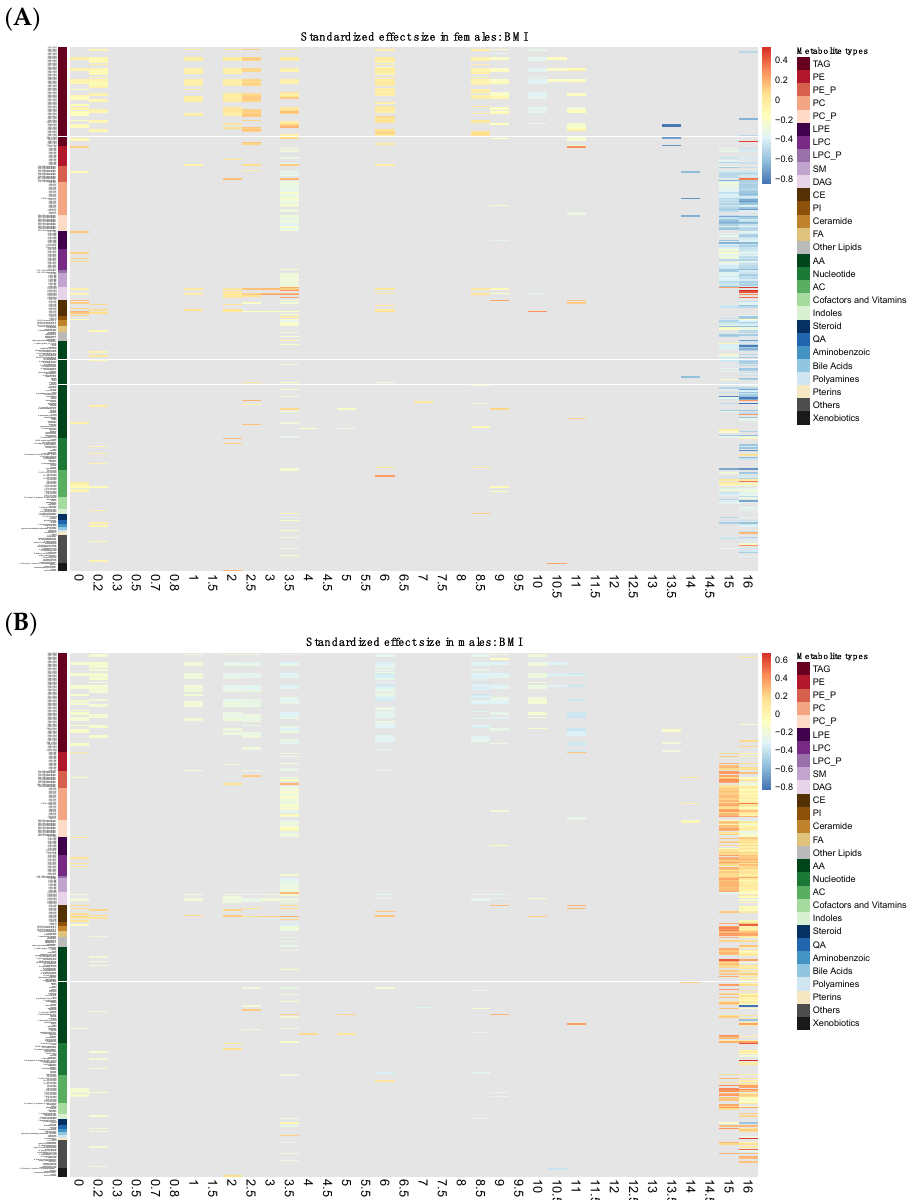
Figure 5. Time-window specific analysis: Heatmap of cord metabolites’ effect size for females ( A ) and males ( B ) on BMI masked by non-significance. The vertical axis represents the 376 metabolites which are ordered based on metabolite types. Effect sizes are standardized by dividing the beta coefficient by the standard deviation of BMI for that sex at that time-window. The color scheme is continuous such that red and blue indicate positive and negative association, respectively. The intensity of the color represents the magnitude of the association. The grey color indicates where the overall effect of that metabolite at that time-window is not statistically significant (LRT FDR >